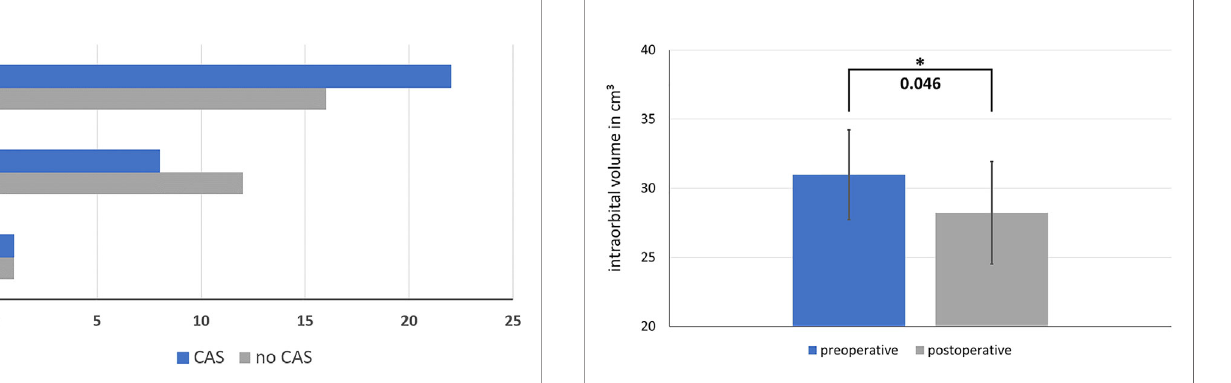
FIGURE 9 | Resection result of the group that was treated using the CAS, compared to the control group. R0: No tumor detectable in the organism R1: Microscopic residual tumor at the resection border R2: Macroscopically tumor or metastases remaining in the patient. Dark blue = intervention group treated with CAS, grey = control group treated without CAS.